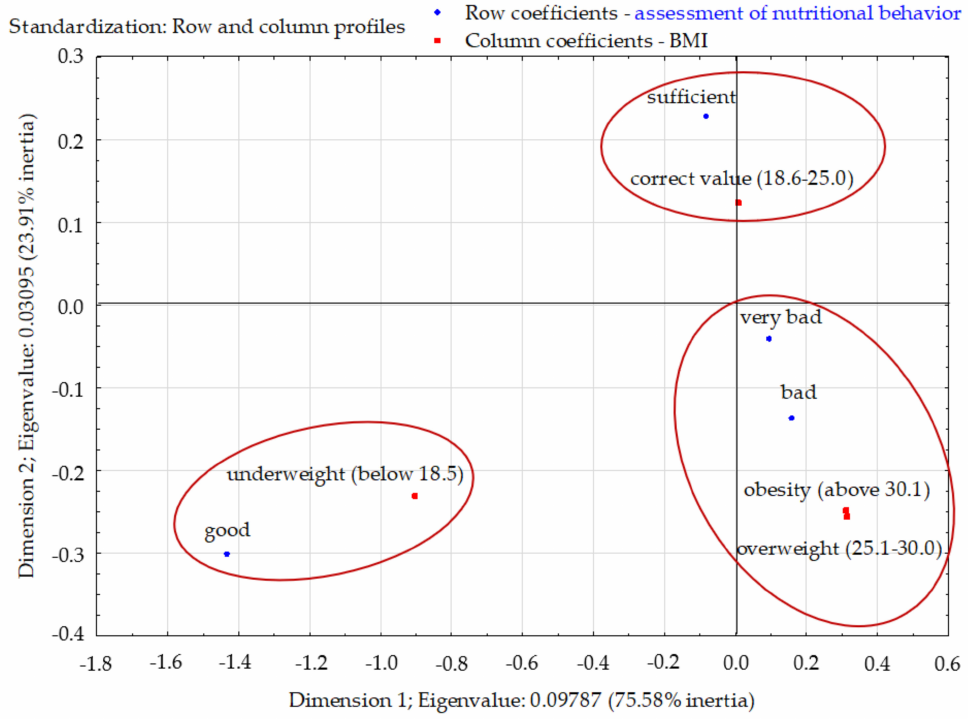
Figure 8. Assessment of nutritional behavior of young Poles and their level of BMI (correspondence analysis). Source: own study based on the research.